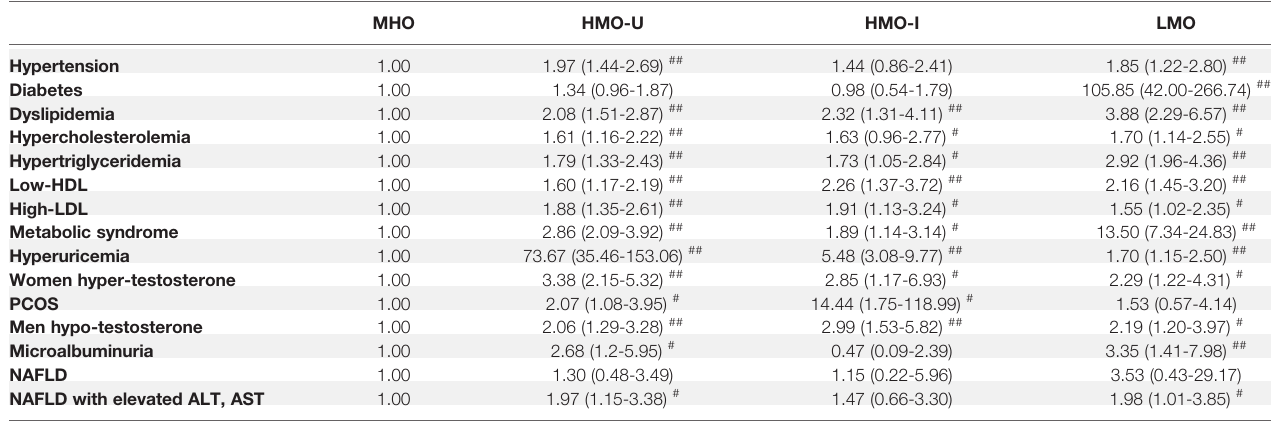
TABLE 5 | The adjusted odds ratio (AOR) of comorbidities across the four clusters generated from Cohort-1 using